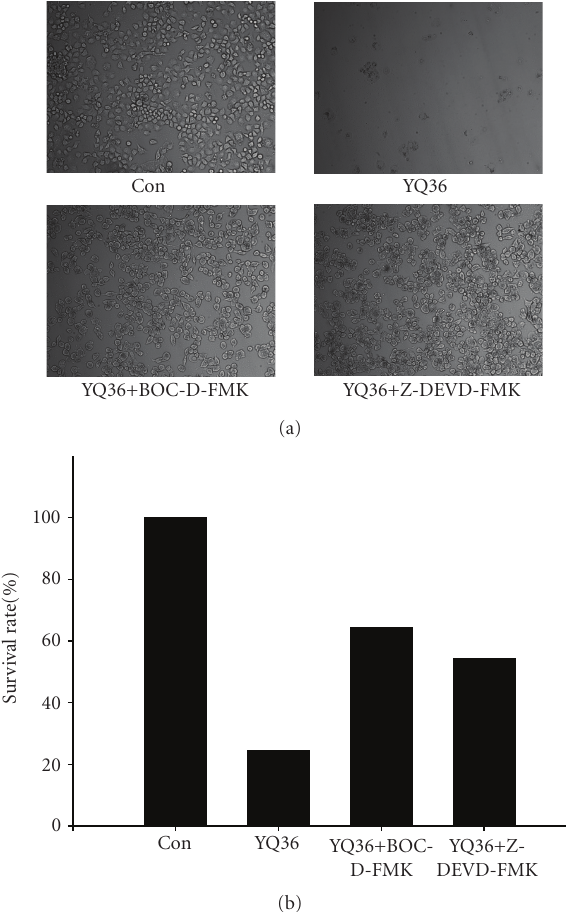
Figure 5: YQ36-caused apoptosis was caspase-dependent. (a) The morphology of KB/VCR cells treated with YQ36 (10 μ M, 48 hours) plus with or without caspase inhibitor (100 μ M BOC-D-FMK and 40 μ M Z-DEVD-FMK) (100 × ). (b) The survival rate of KB/VCR cells treated with YQ36 (10 μ M, 48 hours) plus with or without caspase inhibitor (100 μ M BOC-D-FMK and 40 μ M Z-DEVD-